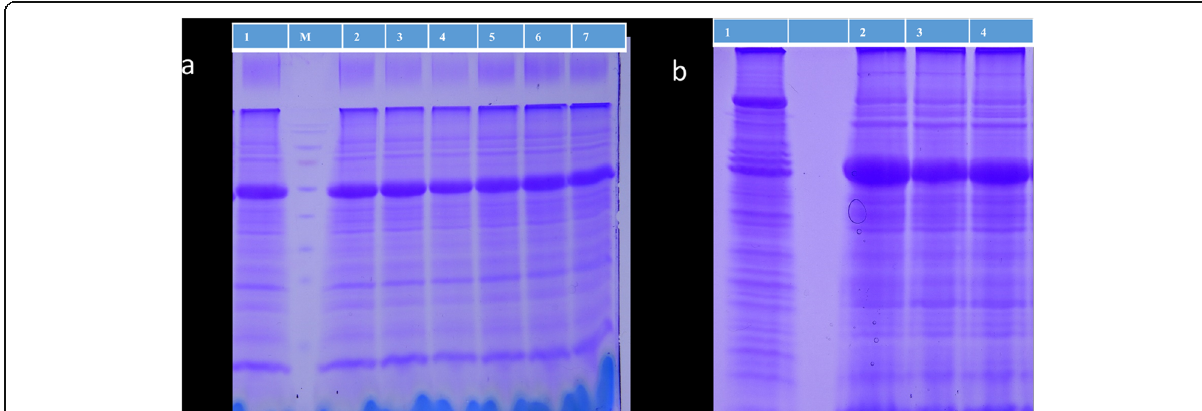
Fig. 3 Representative SDS-PAGE (mass fraction 10%) analysis of total protein, a lane 1- S. bicolor , M-marker, lane 2- cotton, lane 3-TRV1: TRV2